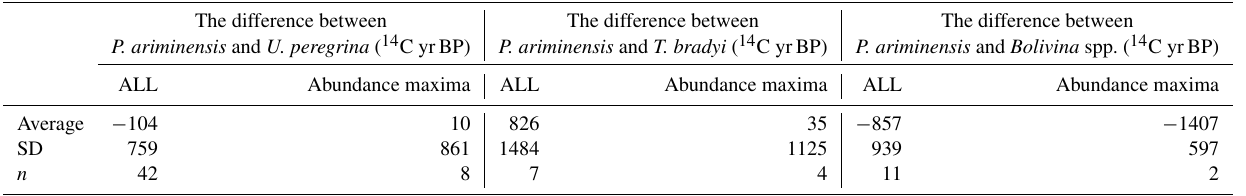
Table 3. Comparison between benthic foraminifera 14 C ages for all measurements (ALL) and only at abundance maxima (see Fig. 4). The difference between The difference between The difference between P. ariminensis and U. peregrina ( 14 C yrBP) P. ariminensis and T. bradyi ( 14 C yrBP) P. ariminensis and Bolivina spp. ( 14 C yrBP) ALL Abundance maxima ALL Abundance maxima ALL Abundance maxima